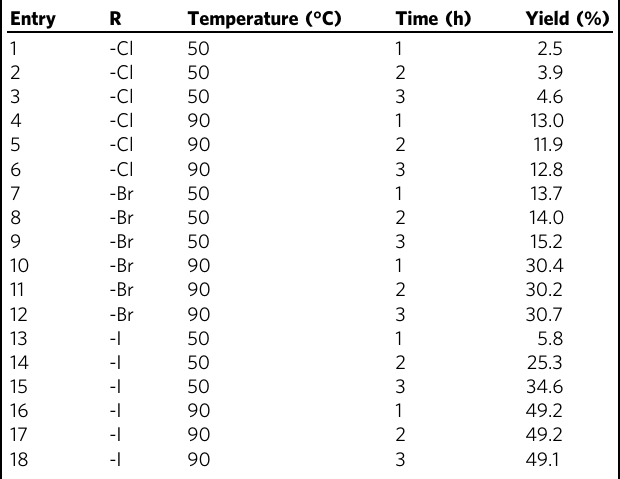
Table 2 SN 2 reaction of AMP (2) with haloacetic acids toward glyphosate